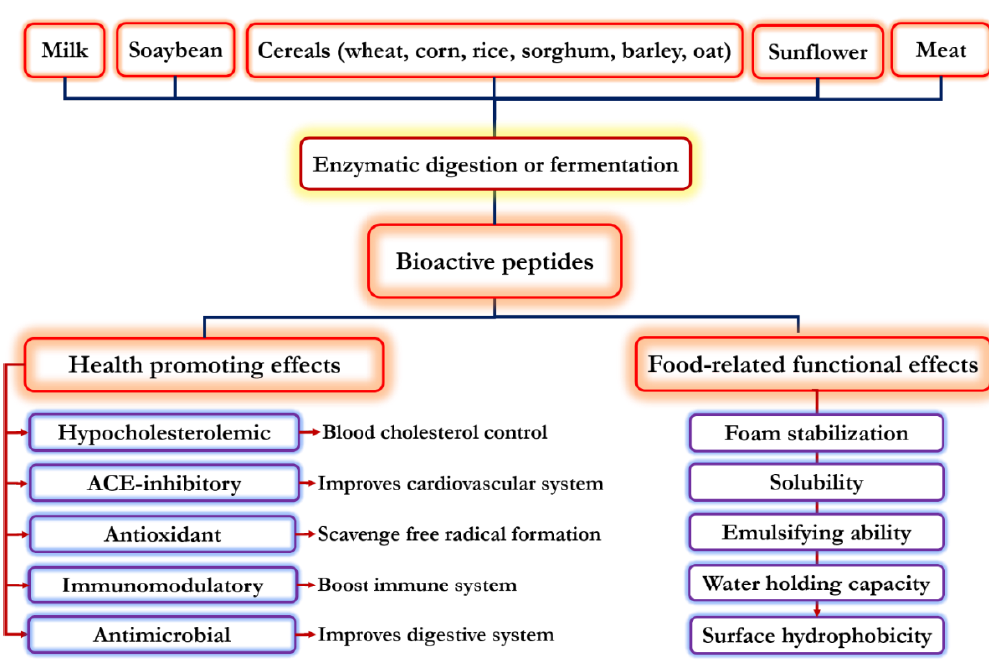
Figure 1. Health-promoting and functional properties of bioactive peptides. ACE, angiotensin-I-converting enzyme.